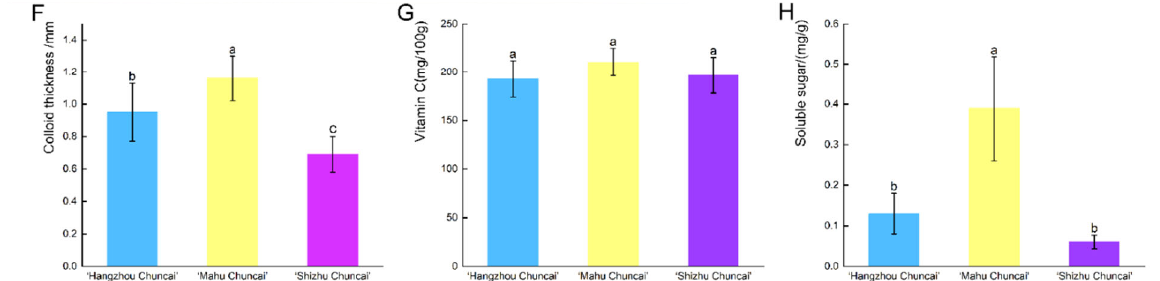
Figure 1. Comparison of morphology and nutrition in different varieties of B. schreberi . ( A ) Color and size of leaves of B. schreberi ; ( B – E ) Determination of the growth index of varieties of B. schreberi ; ( F – H ) Differences in contents of young bud of three varieties; different lowercase letters (a, b, c) indicate significant differences between different treatments at the 5% significant level. 30 leaves from each variety were randomly selected for each morphological index measurement.